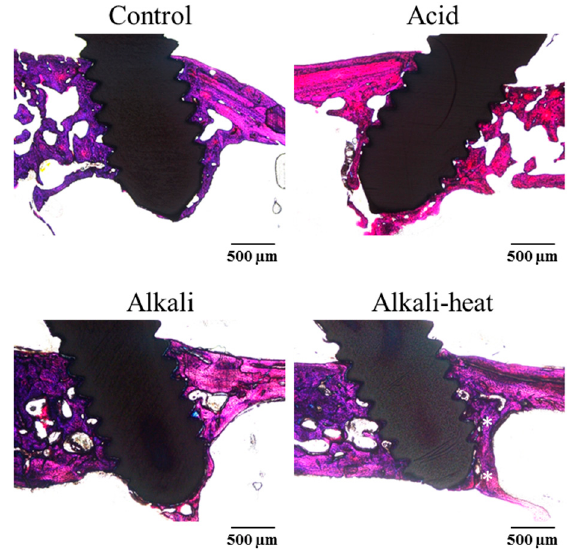
Figure 10. Histological appearances of bone formation around different MDF-Ti implants after 6 weeks of implantation. Table 5. Percentage of the measured BIC